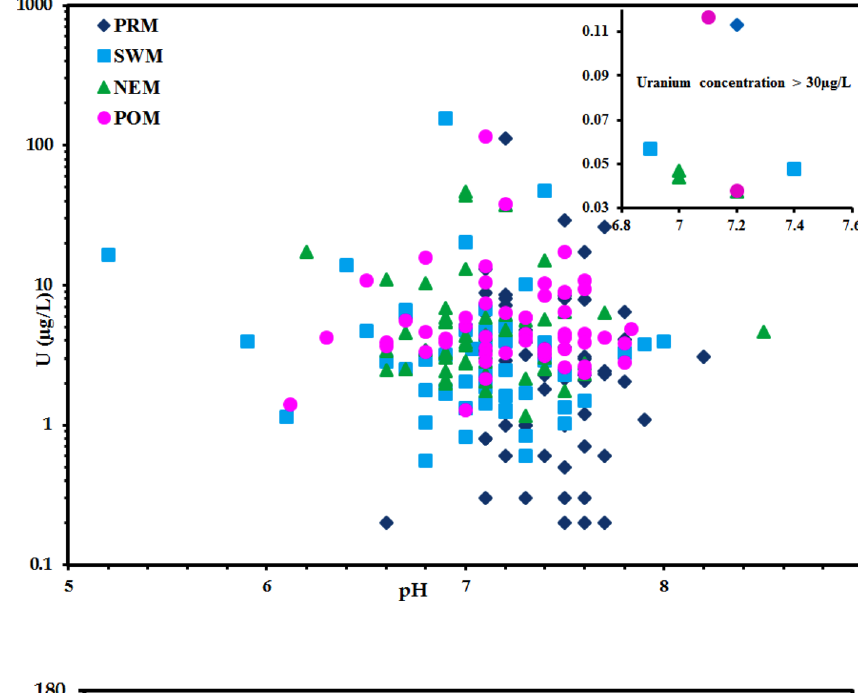
Fig. 7 Seasonal variation of ORP with respect to U in